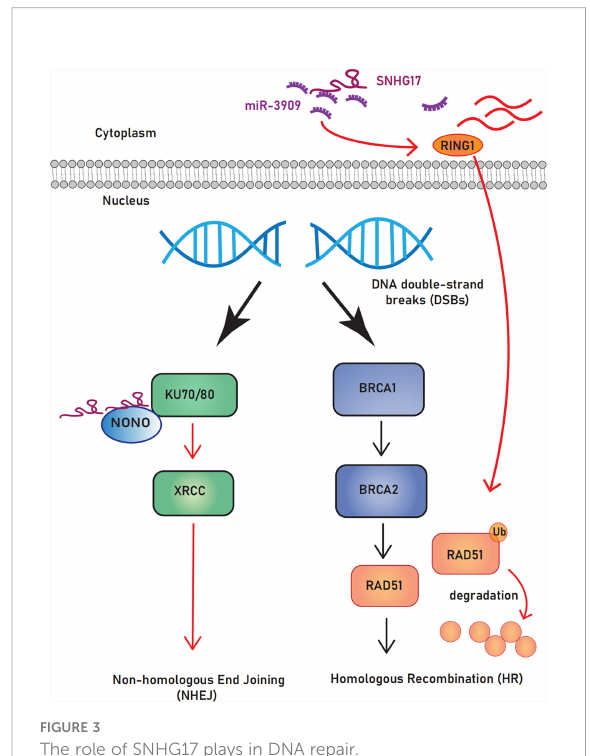
FIGURE 3 The role of SNHG17 plays in DNA